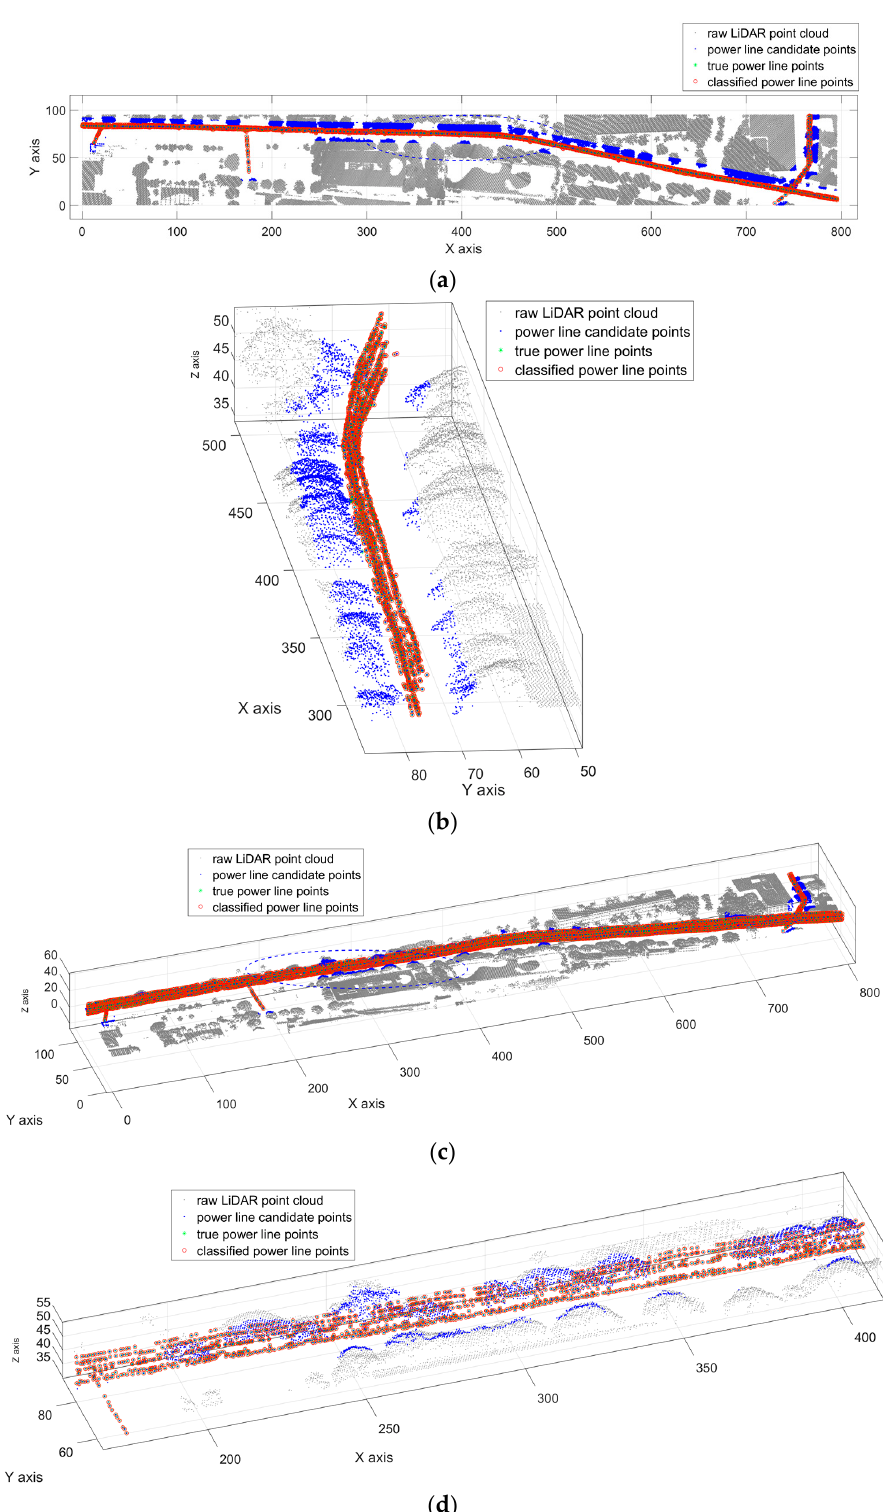
Figure 6. Visualization of the experiment results for power line classification of LP Dataset. ( a ) is the whole area results in XOY plane involving the raw LiDAR point cloud, power line candidate points, true power line points and classified power line points; ( b ) is the local magnification of the blue dashed ellipse area in ( a ) in power line corridor direction; ( c ) is the whole area results in 3D view; ( d ) is the local magnification of the blue dashed ellipse area in ( c ).